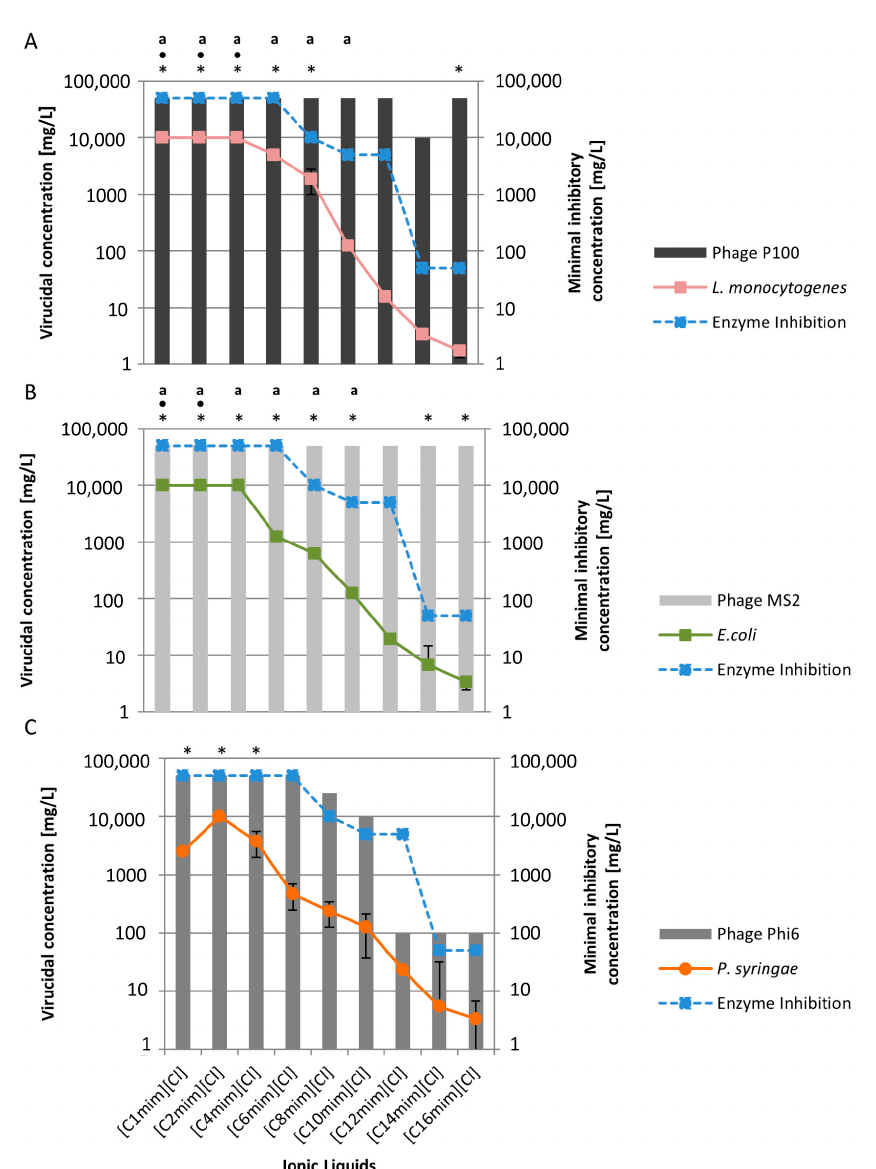
Figure 2. Virucidal concentration of imidazolium ionic liquids with increasing side chain length and the respective standard deviation using virus P100 ( A ); MS2 ( B ) and Phi6 ( C ) and the corresponding minimal inhibitory concentration of the host bacteria L. monocytogenes ( A ), E. coli ( B ) and P. syringae ( C ) and enzyme inhibition (blue line) . (*) No virucidal effect was observed at a concentration of 50,000 mg/L. (•) No bactericidal effect was observed at a concentration of 10,000 mg/L. ( a ) calculation based on data of Fister et al. [30].